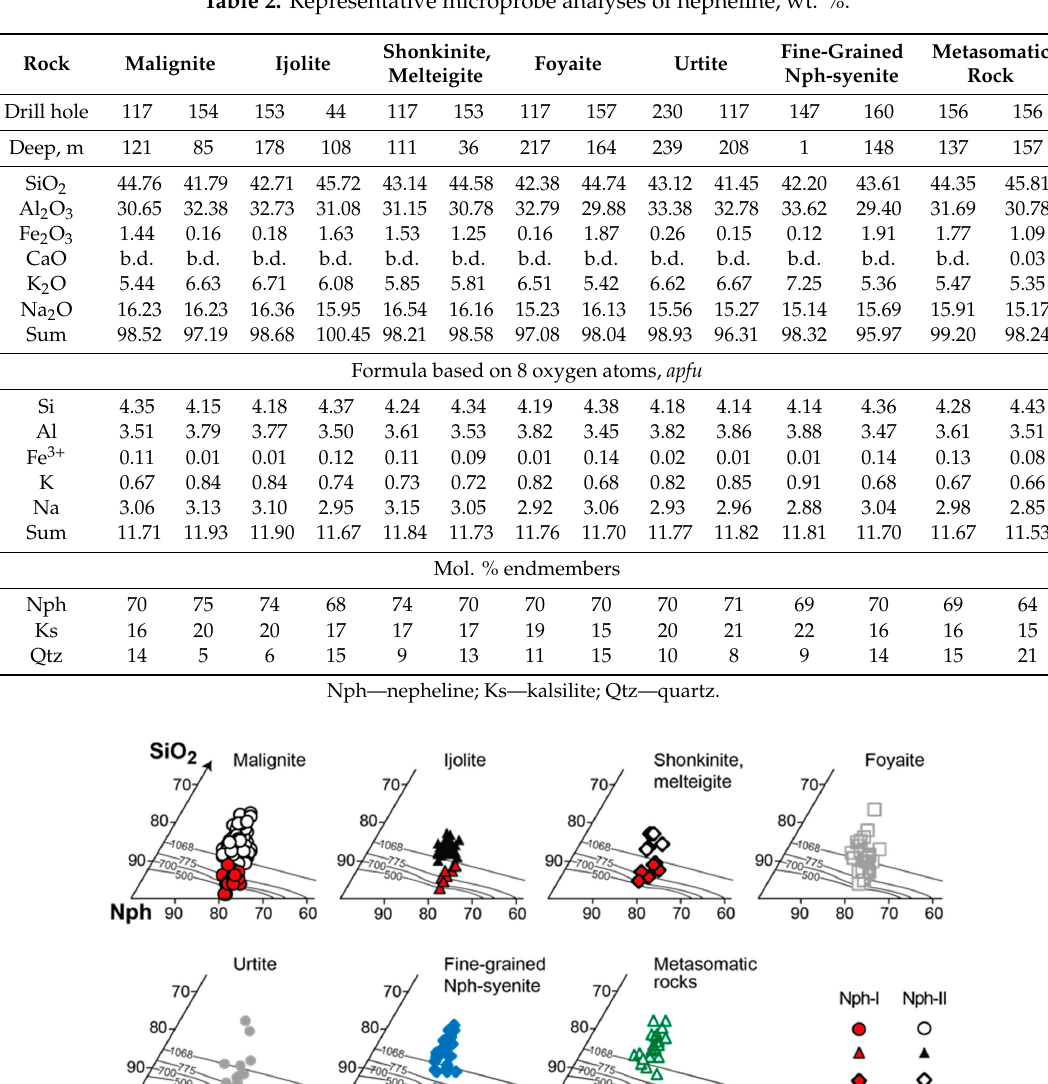
Table 2. Representative microprobe analyses of nepheline, wt. %.